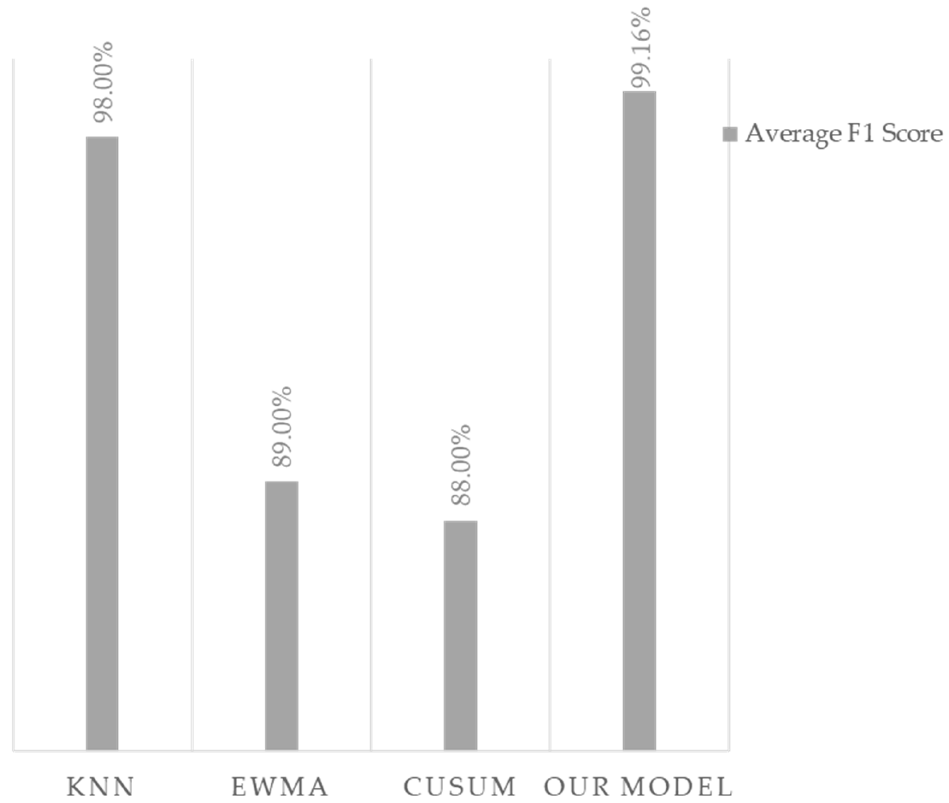
Figure A7. Comparison of the F1 score of EWMA, CUSUM, and KNN with our model.